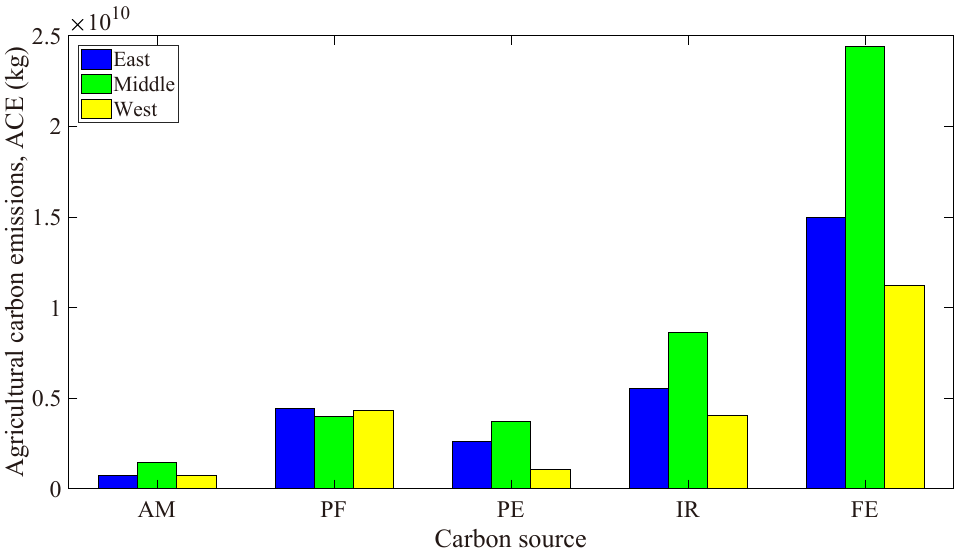
Figure 6. Regional agricultural carbon emission (ACE, kg) by carbon source, 2019.